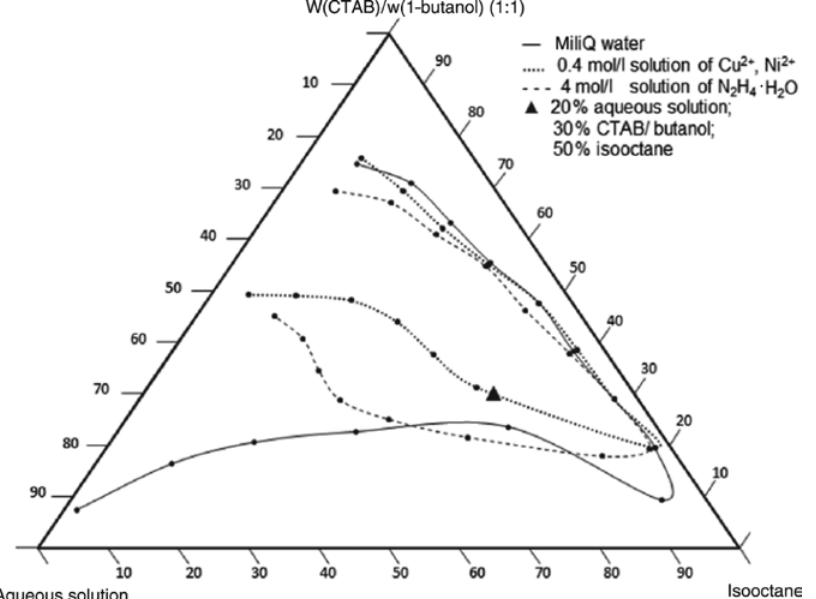
Figure 7: Region of microemulsion stability is indicated as a function of the concentrations of reagents in the solution. Composition of the reverse micelles used to synthesize the particles is marked with ▴. Reproduced with permission from IEEE: Transactions on Magnetism [40].